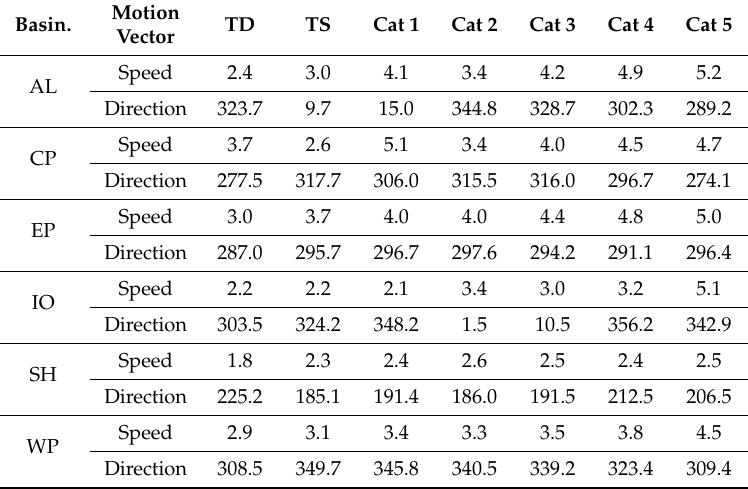
Table 4. Averaged motion vector at each intensity category over each TC basin. (Direction: clockwise from the North in degree; Speed unit: m s − 1 ).